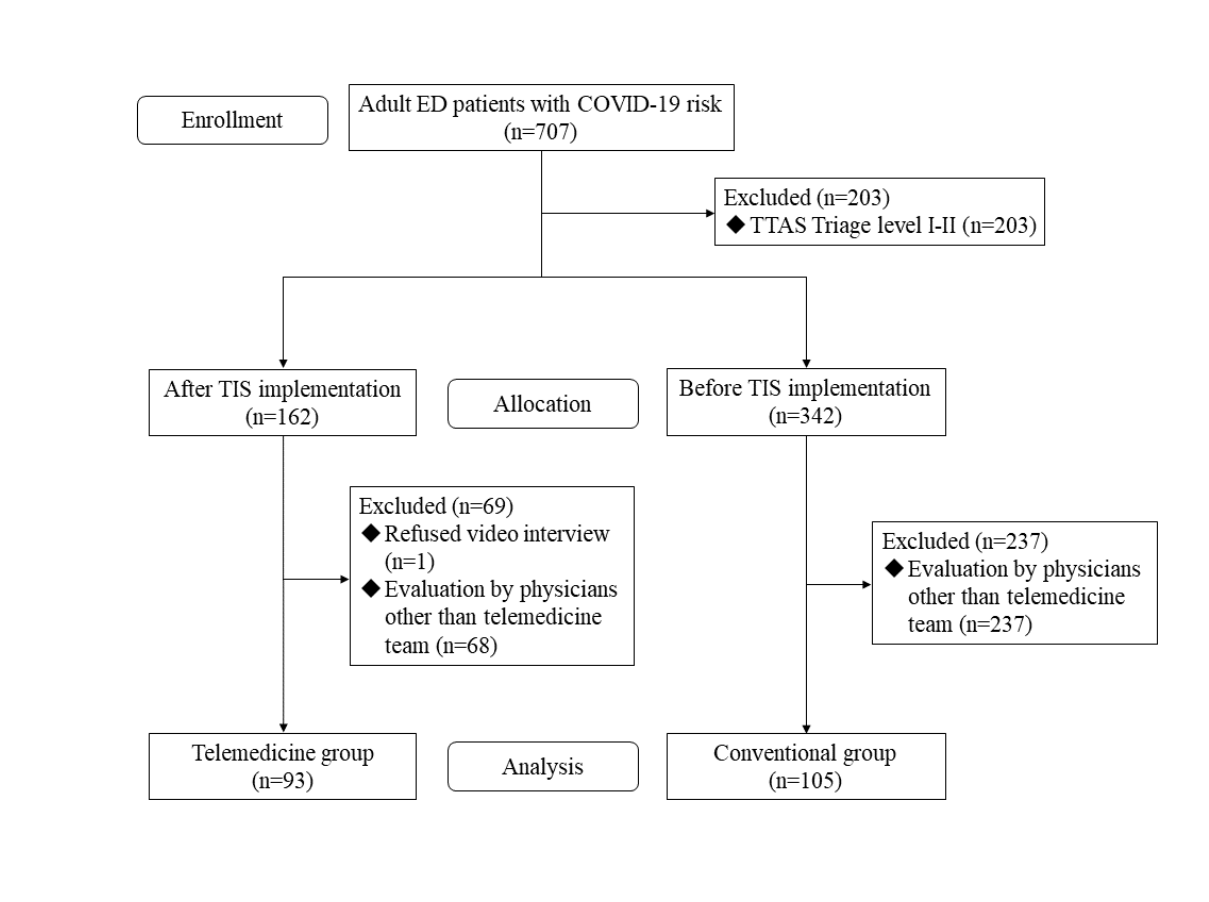
Figure 2. Flowchart of patient disposition. COVID-19: coronavirus disease; ED: emergency department; TTAS: Taiwan Triage and Acuity